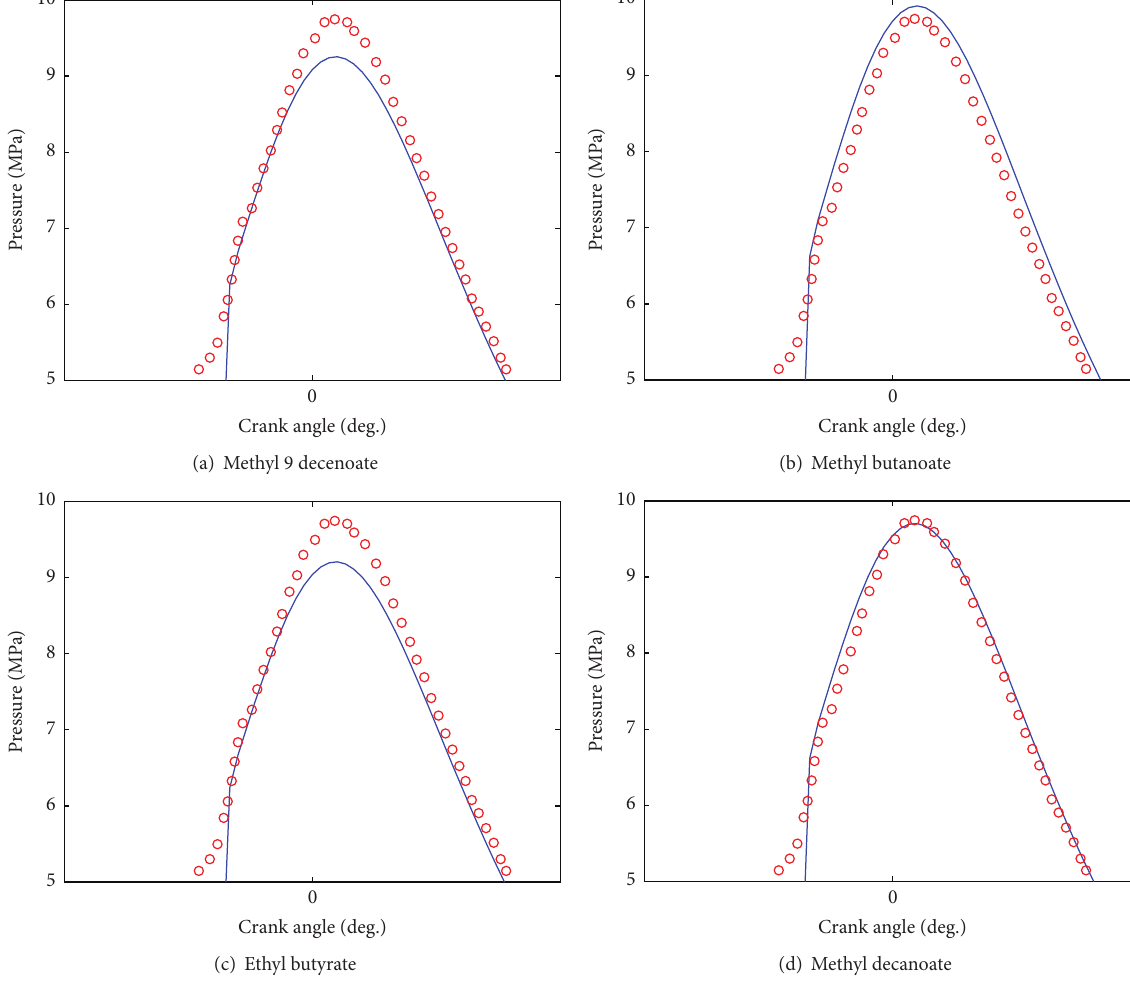
Figure 4: Experimental and simulated pressure trace at 1700 RPM for MEB for each